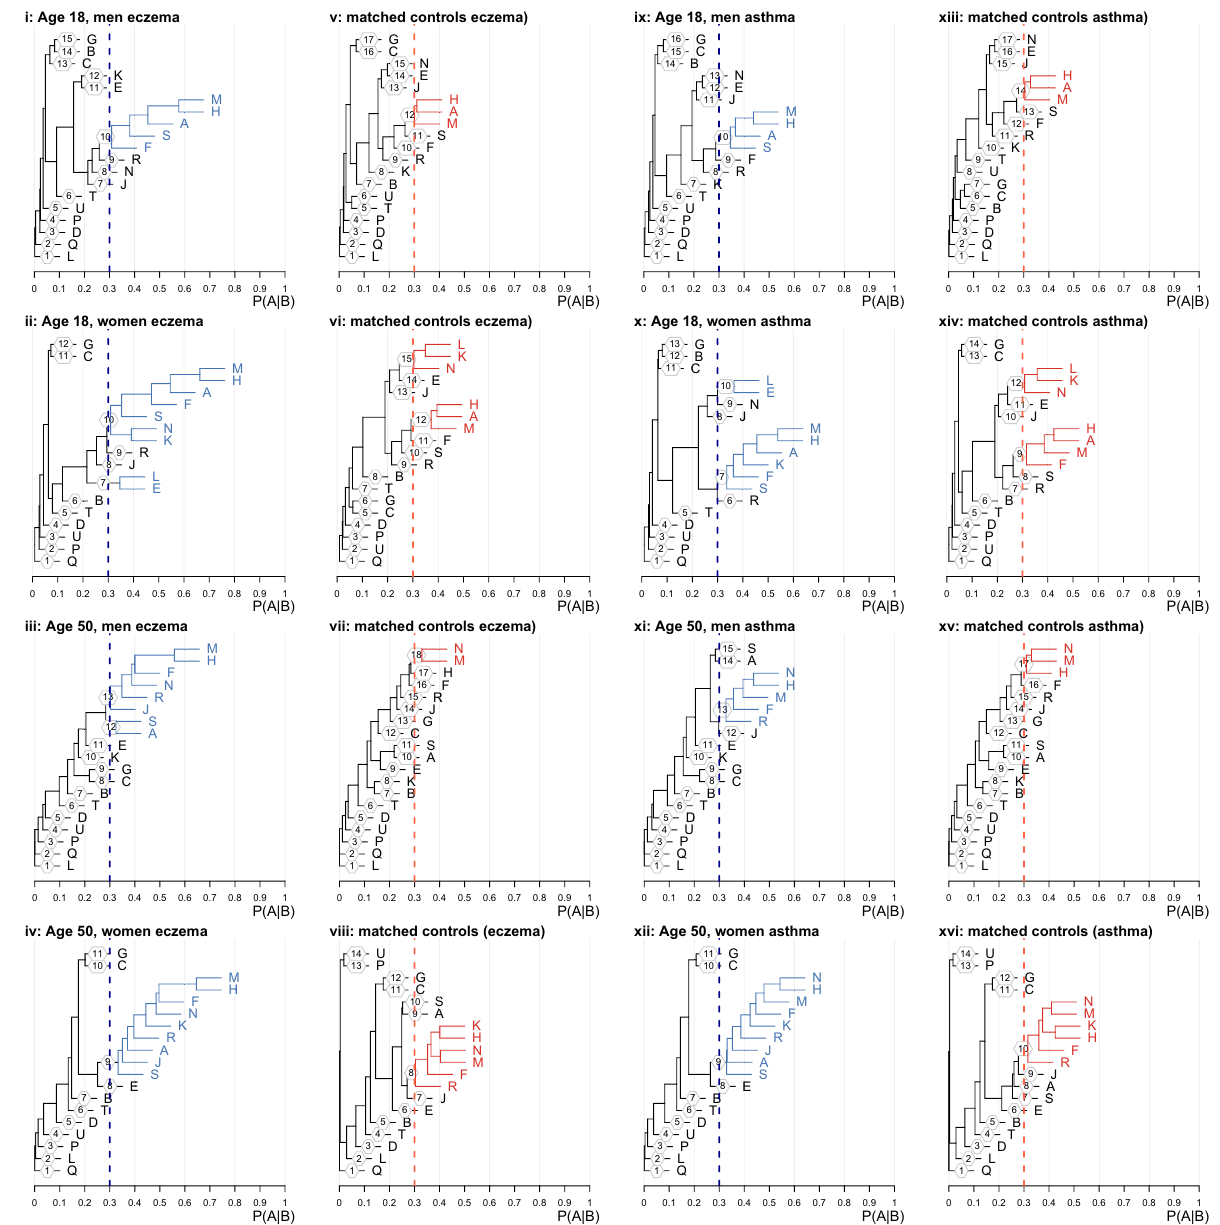
Figure 3. Dendrograms showing Read code chapters that cluster together in men and women with eczema (panels A–D) and without eczema (E–H) and in men and women with asthma (J–M) and without asthma (N–Q). Clusters of chapters with a greater than 30% probability of co-occurrence within 5 years are shown in color (Blue, eczema/asthma. Red, controls). All probabilities are calculated at 5 years’ followup from the first chapter recording. A: Infectious/parasitic diseases, B: Neoplasms, C: Endocrine/metabolic, D: Blood diseases, E: Mental disorders, F: Nervous system/senses, G: Circulatory system, H: Respiratory system, J: Digestive system, K: Genito-urinary system, L: Pregnancy/childbirth, M: Skin/subcutaneous, N: Musculoskeletal, P: Congenital anomalies, Q: Perinatal conditions, R: Ill-defined conditions, S: Injury/poisoning, T: Causes of injury/poisoning, U: External